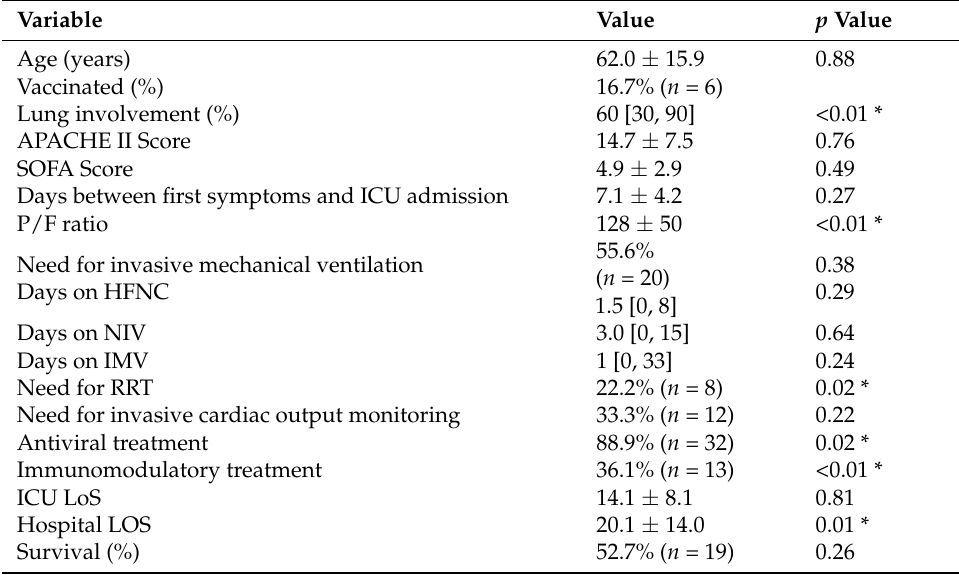
Table 2. Risk factors for increased costs in the COVID-19